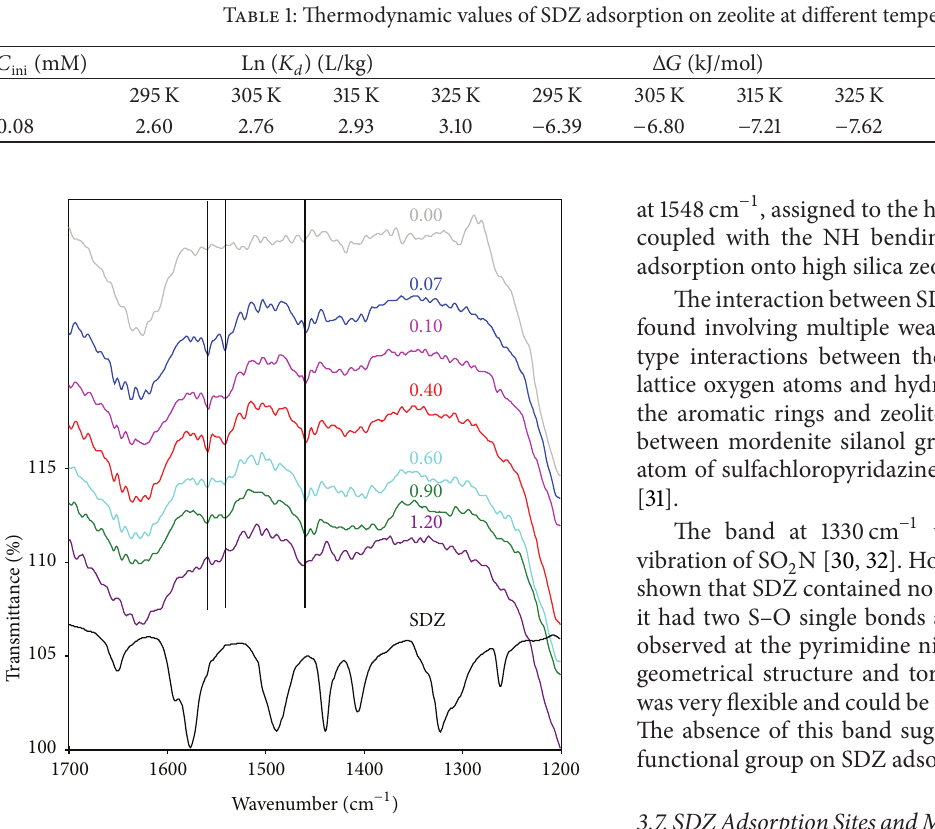
Figure 7: FTIR spectra of raw zeolite, solid SDZ and SDZ-adsorbed zeolite with different amounts of SDZ. The vertical lines are new peaks after SDZ adsorption on